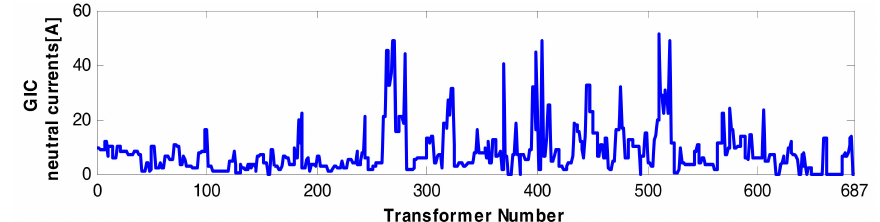
Figure 6. Transformer neutral currents (in absolute